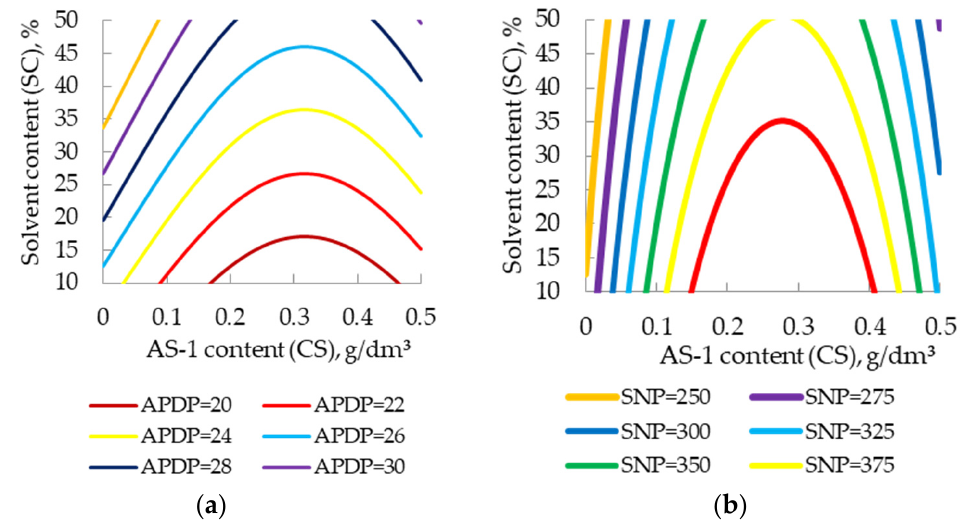
Figure 9. Two-factor nomograms: ( а ) SNP = f (SC, CS); ( b ) APDP = f (SC, CS).